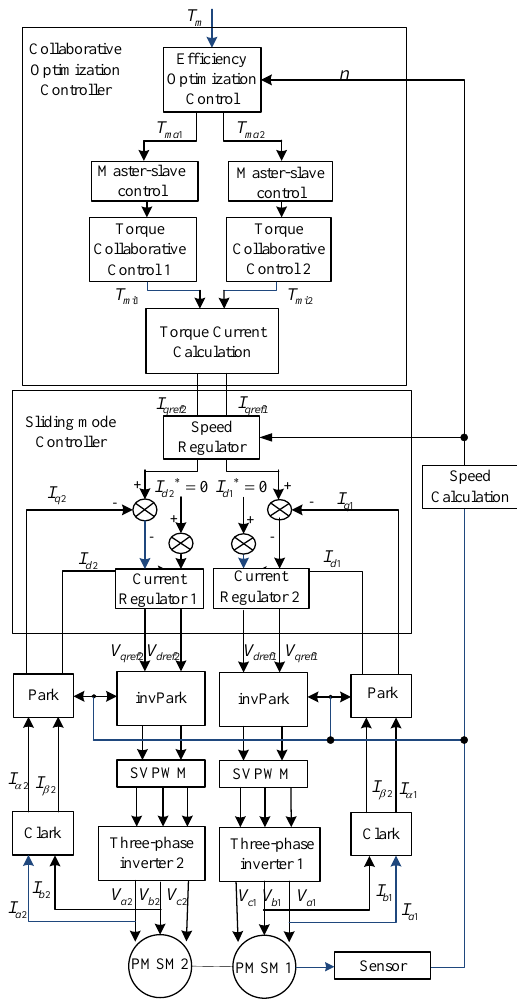
Figure 2. Block diagram of collaborative optimization control-based drive system.